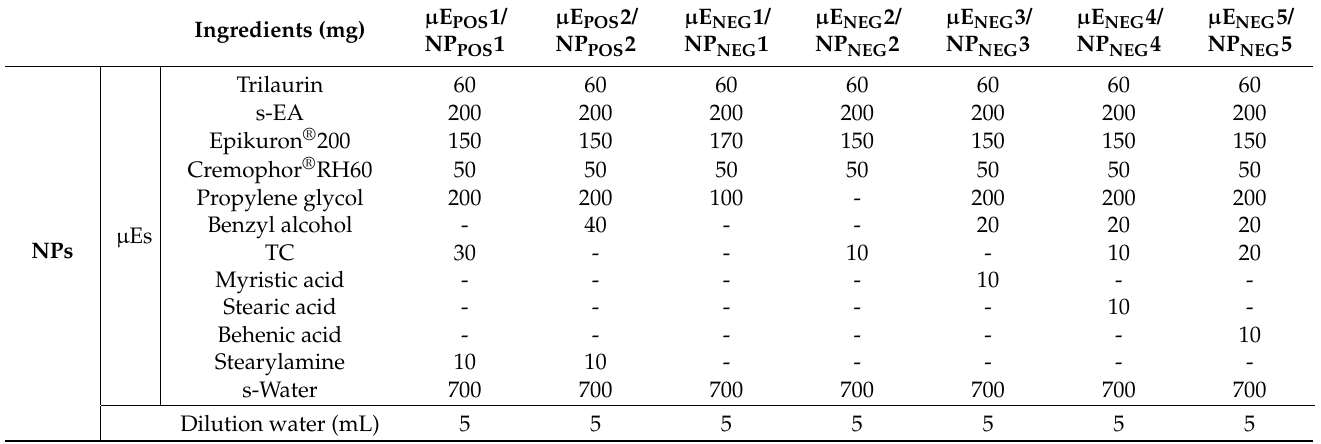
Table 1. Composition of µ Es and corresponding NPs prepared with different charging